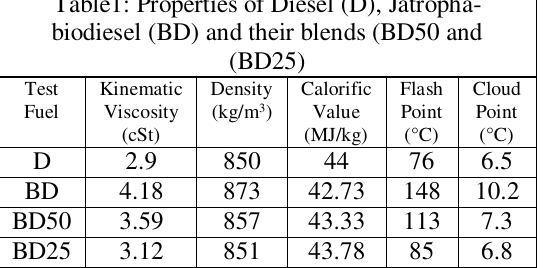
Table1: Properties of Diesel (D), Jatropha- biodiesel (BD) and their blends (BD50 and (BD25)